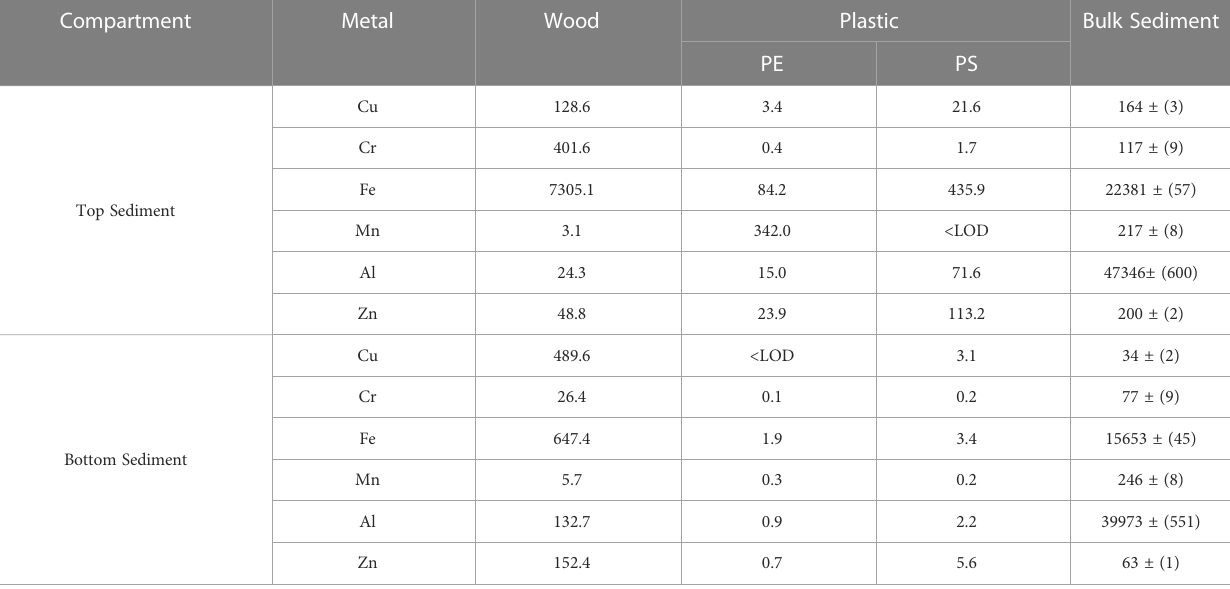
TABLE 1 Metal concentrations in µg/g extracted from wood controls and plastic (PE and PS) exposed to the top and bottom harbor sediment for 6 months, compared to the bulk sediment. Compartment Metal Wood Plastic Bulk Sediment PE PS